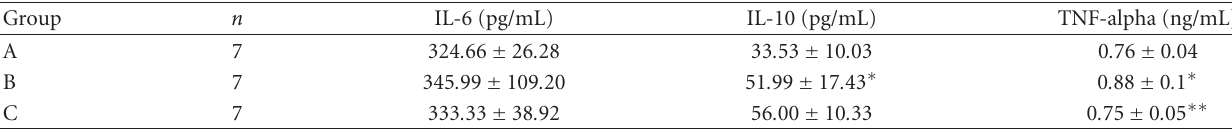
Table 3: Comparison of plasma cytokine